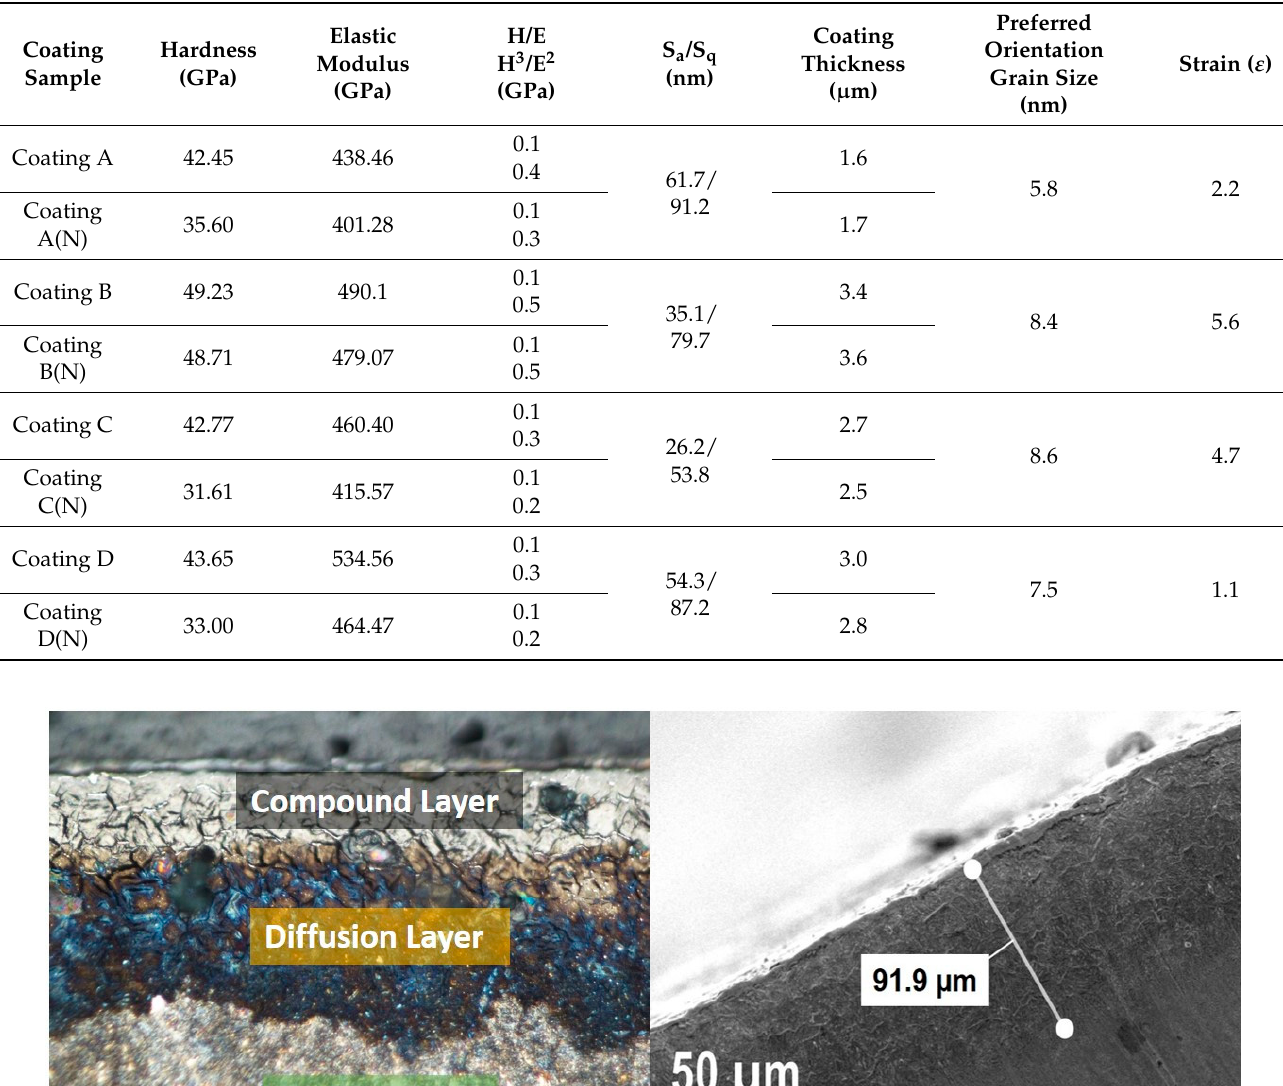
Table 3. Mechanical and structural properties of the coatings.